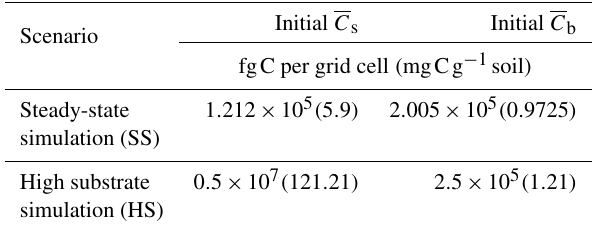
Table A2. Initial mean substrate and microbial C in scenarios SS and HS, expressed in both femtograms of carbon (fgC) per grid cell and milligrams of carbon per gram of soil (values in